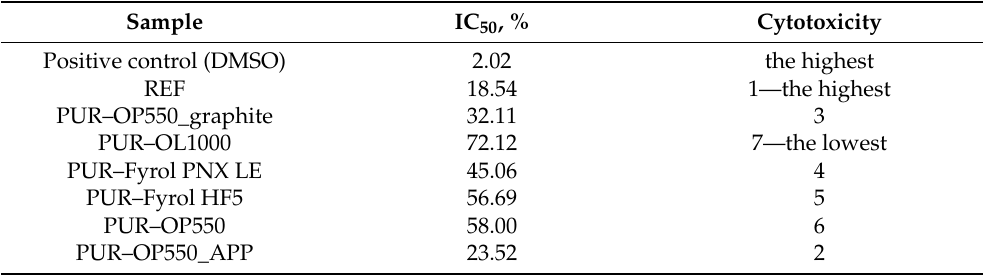
Table 10. IC 50 values of foam extracts after the 24-h exposure of human keratinocyte cell line HaCaT evaluated based on cytotoxicity curves.